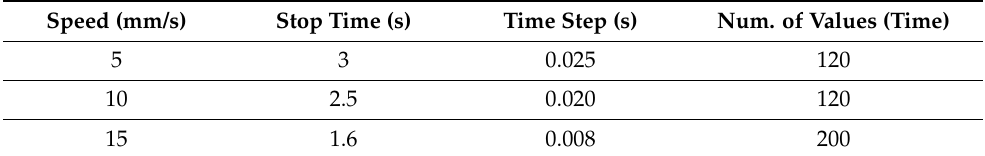
Table 4. Parameters of time-dependent solver.